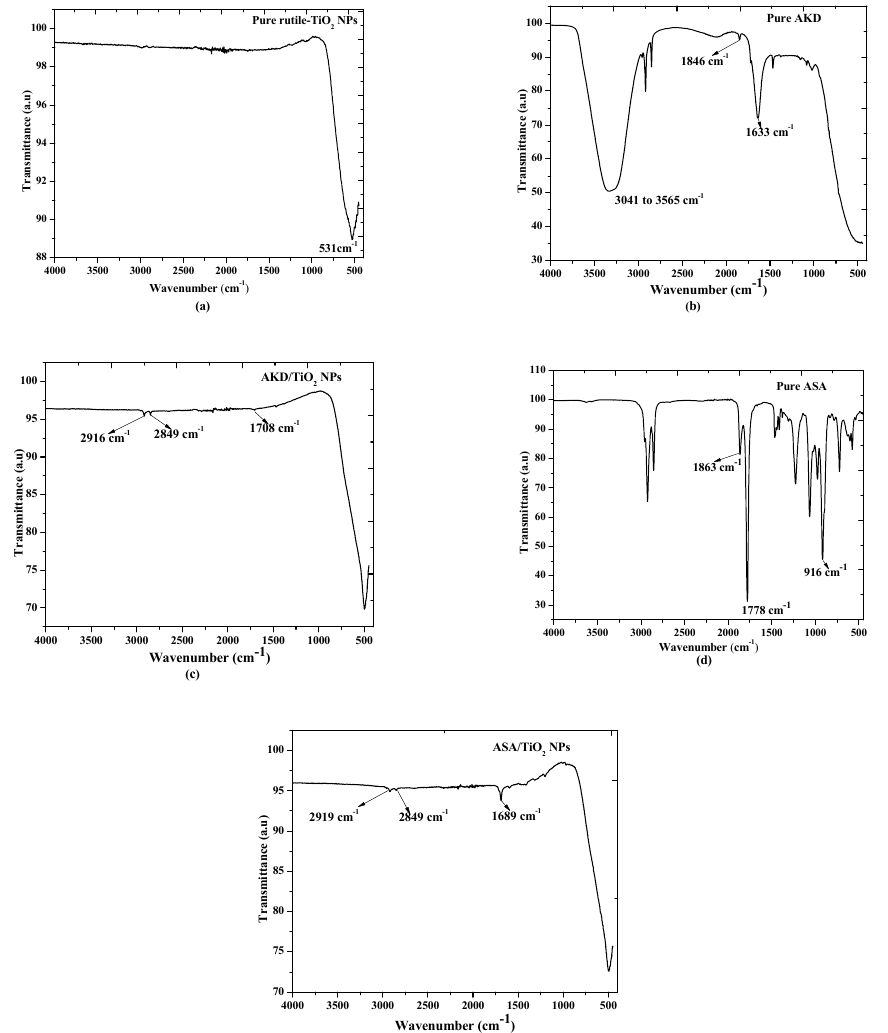
Figure 9. Fourier-transform infrared spectra: ( a ) pure rutile-TiO 2 NPs; ( b ) pure AKD; ( c ) AKD surface-modified rutile-TiO 2 NPs; ( d ) pure ASA; ( e ) ASA surface-modified rutile-TiO 2 NPs.